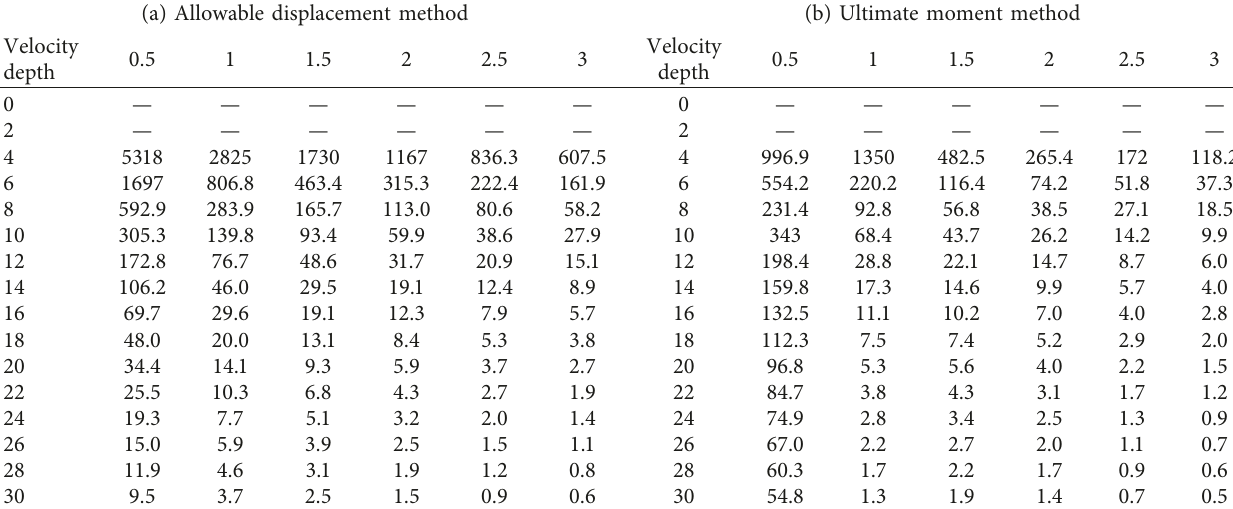
Table 6: Safety factors for different scour and flow velocity